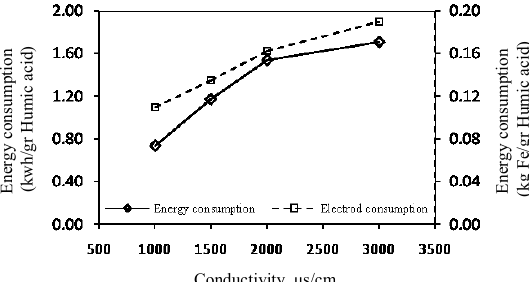
Figure 10. Effect of conductivity on the electrical energy and electrode consumption (initial concentration of HA: 20 mg L -1 , pH: 5, applied voltage: 50 V, reaction time: 75